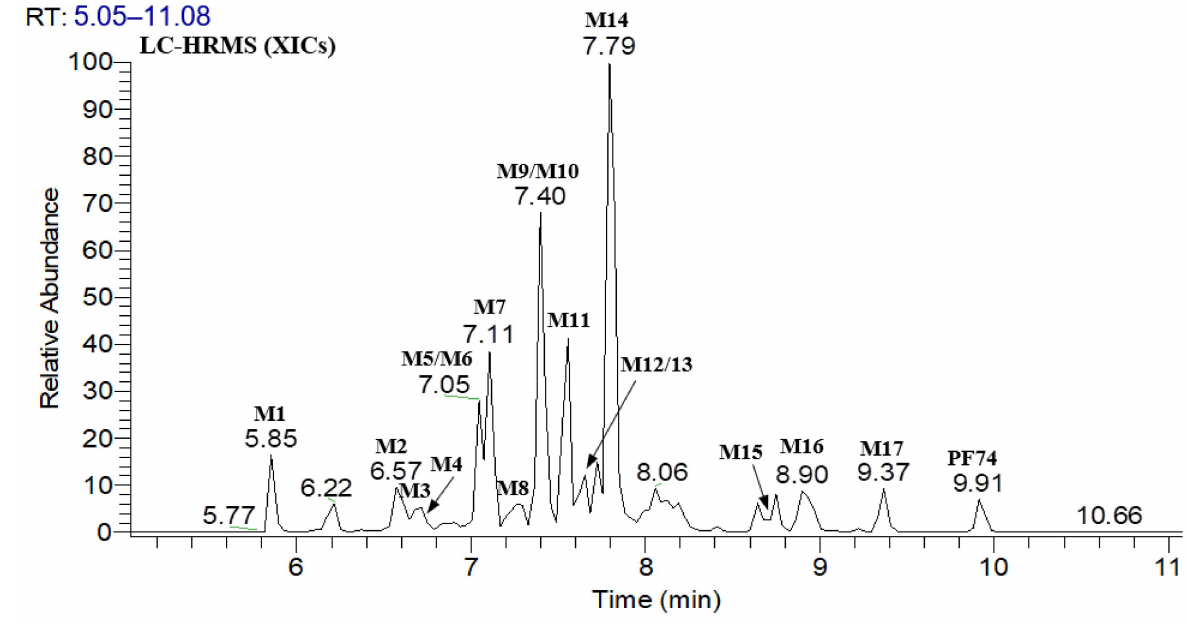
Figure 2. UPLC – UV (254 – 310 nm) chromategrams of PF74 in HLMs: ( A ) UPLC – UV spectrum of T60 Figure 2. UPLC–UV (254–310 nm) chromategrams of PF74 in HLMs: ( A ) UPLC–UV spectrum of T60 (M1 and M15 are not listed due to weak UV absorption); ( B ) UPLC–UV spectrum of T0; ( C ) blank (M1 and M15 are not listed due to weak UV absorption); ( B ) UPLC – UV spectrum of T0; ( C ) blank UPLC–UV spectrum. UPLC – UV spectrum.